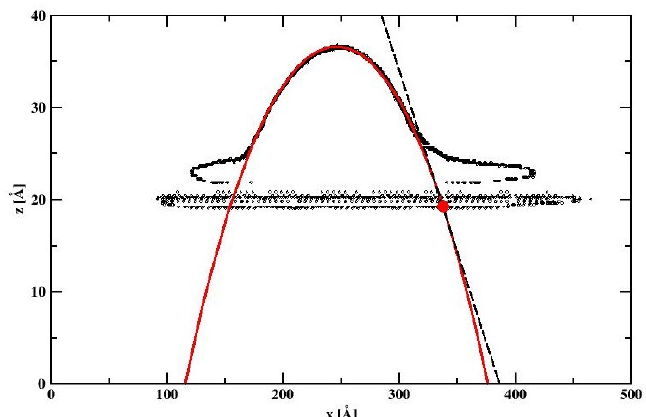
Figure 11. The cylindrical droplet contour calculated for the water–silicon dioxide surface system. The circles denote the position of the water density profile with value 0.5 ± 0.03 g/cm 3 . The thick red line denotes the droplet profile obtained by applying the fitting procedure. The dashed line denotes the line tangent to the drop that meets the bottom of the nanodroplet at the big red point. WCA dependence on hydrocarbon surface coverage for water nanodroplets on n-decane covered bare silicon surface.